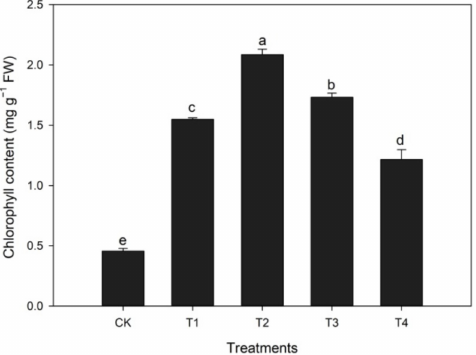
Figure 2. Chlorophyll (Chl) content in leaves of Rosa hybrida ‘Carolla’ under heat stress. Plants were treated with 50 µ M CaCl 2 (T1), 100 µ M CaCl 2 (T2), 150 µ M CaCl 2 (T3), 200 µ M CaCl 2 (T4), or H 2 O as the control (CK). Each vertical line shows the standard error ( n = 10). The values are described as means ± SD; different letters denote significant differences ( p < 0.05) according to Duncan’s multiple range tests.